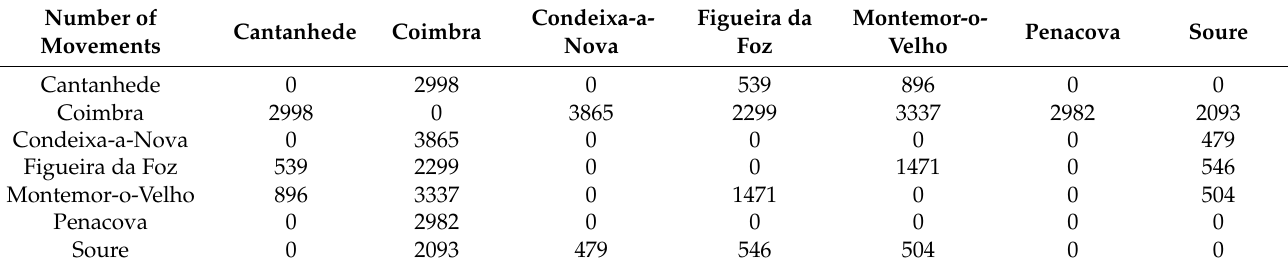
Table 5. Number of movements of active